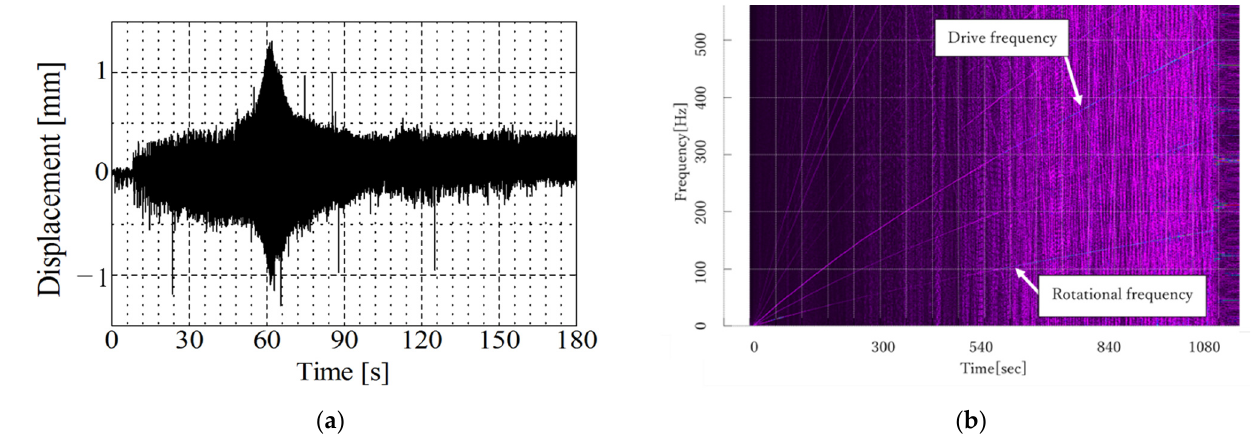
Figure 13. Results of ( a ) time and ( b ) frequency response for flywheel swing displacement.